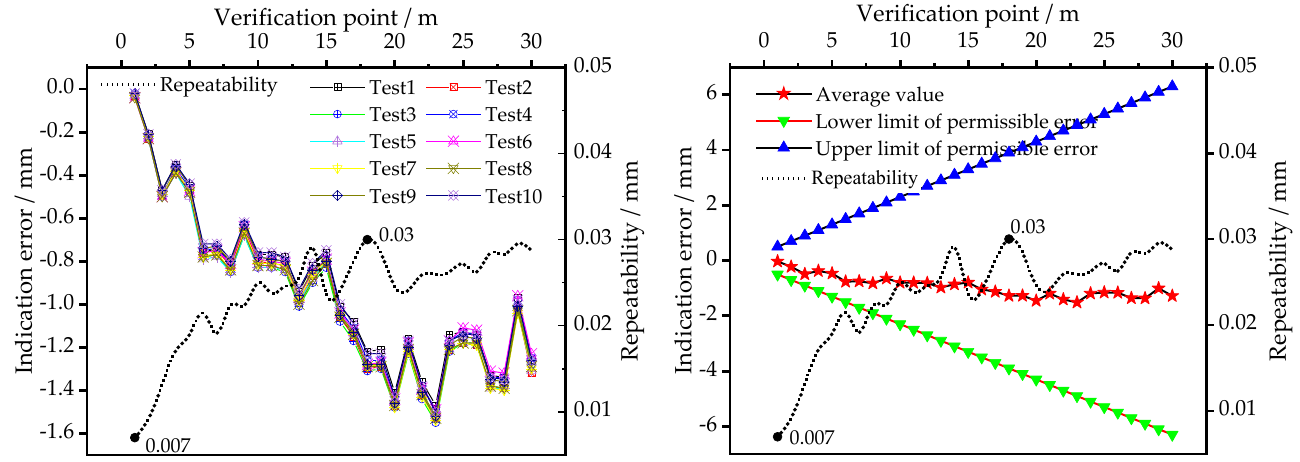
Figure 15. Indication error test of 30 m swing-type steel measuring tape. The variation trend of the indication error value of each test object is consistent, and